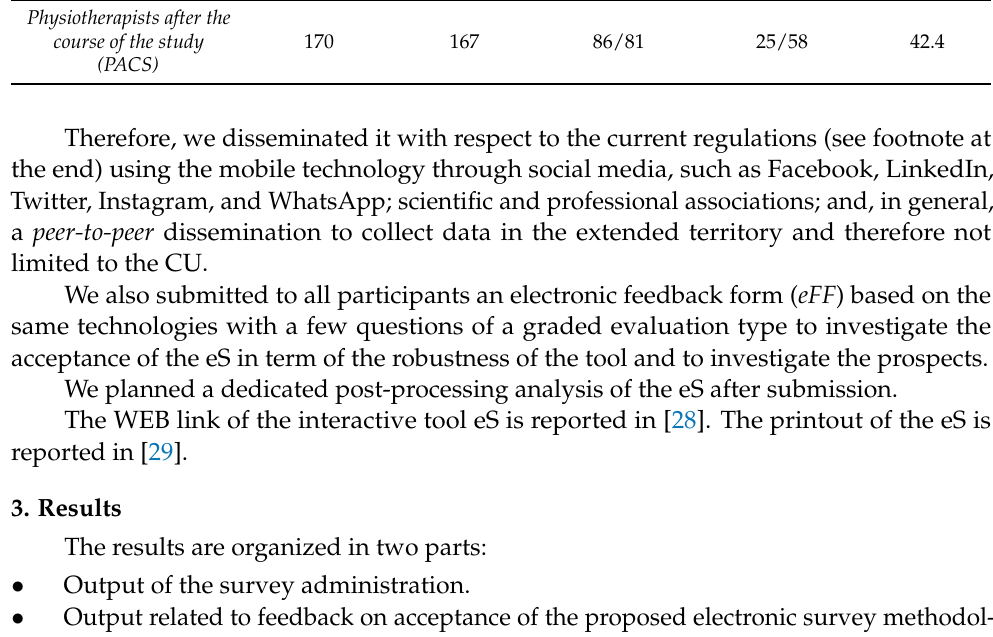
Table 1. Characteristics of the participants in the two electronic-based submissions: the PUCS and the PACS. Number Participants Males/Females Submission Invited